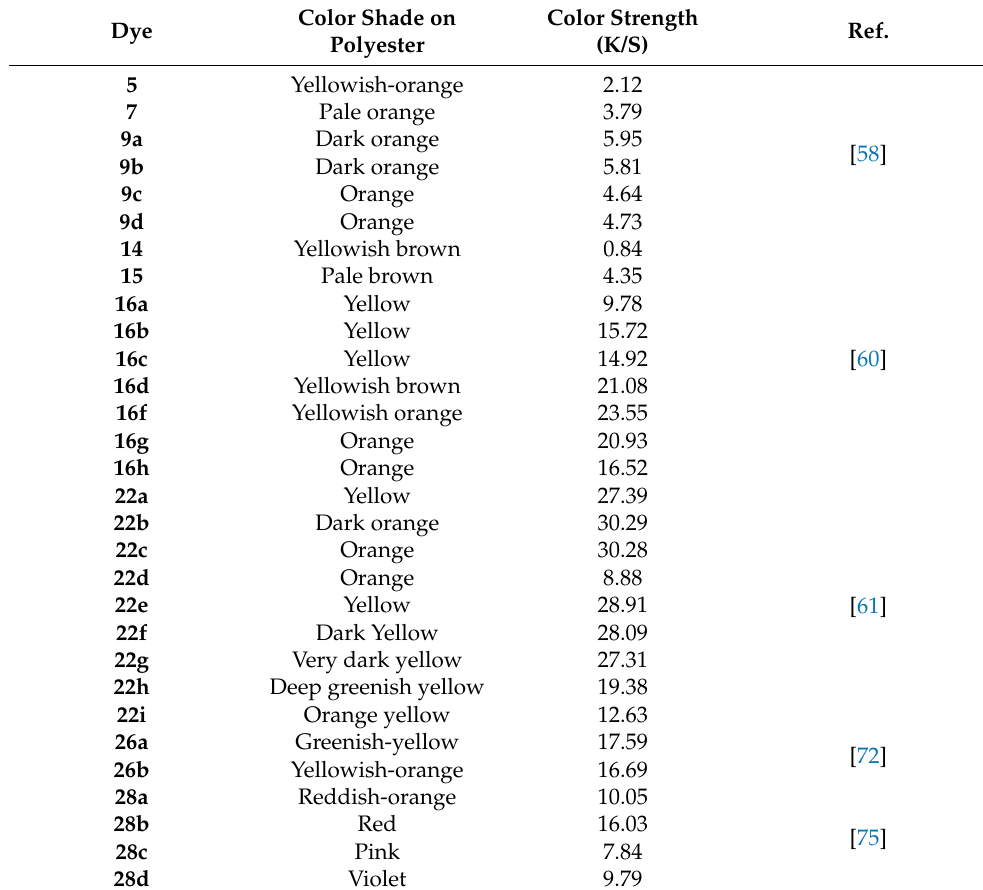
Table 1. K/S of polyester fabrics dyed with synthesized dyes 130 ◦